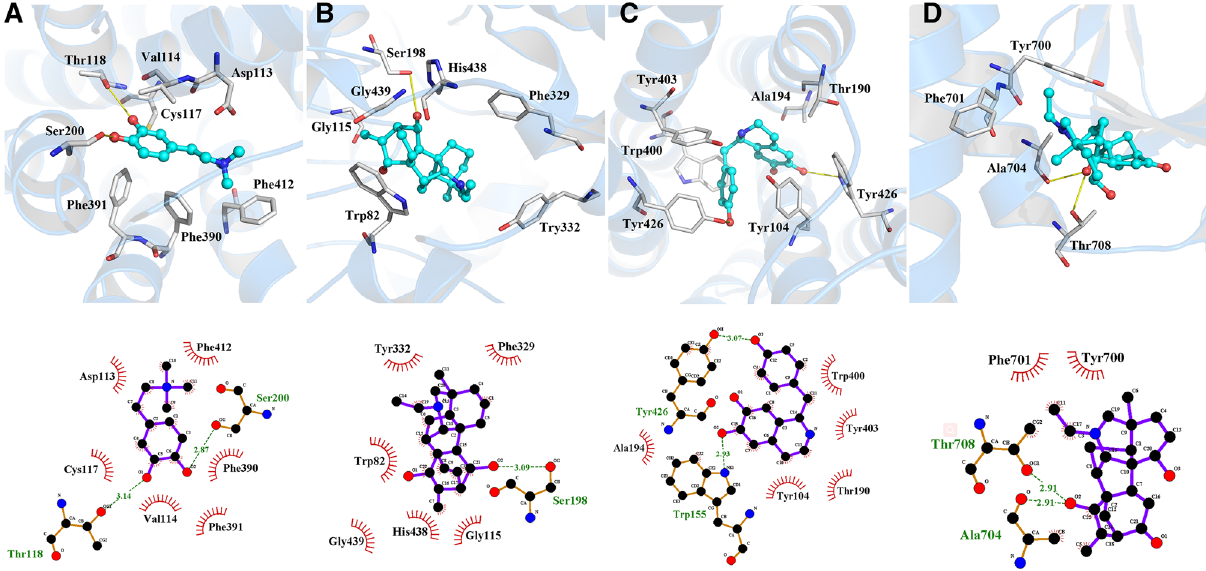
Figure 2. Molecular docking simulation for bioactive ingredients and target proteins. (A) Coryneine and ADRA2A, (B) denudatine and BCHE, (C) norcoclaurine and CHRM2, (D) songorine and